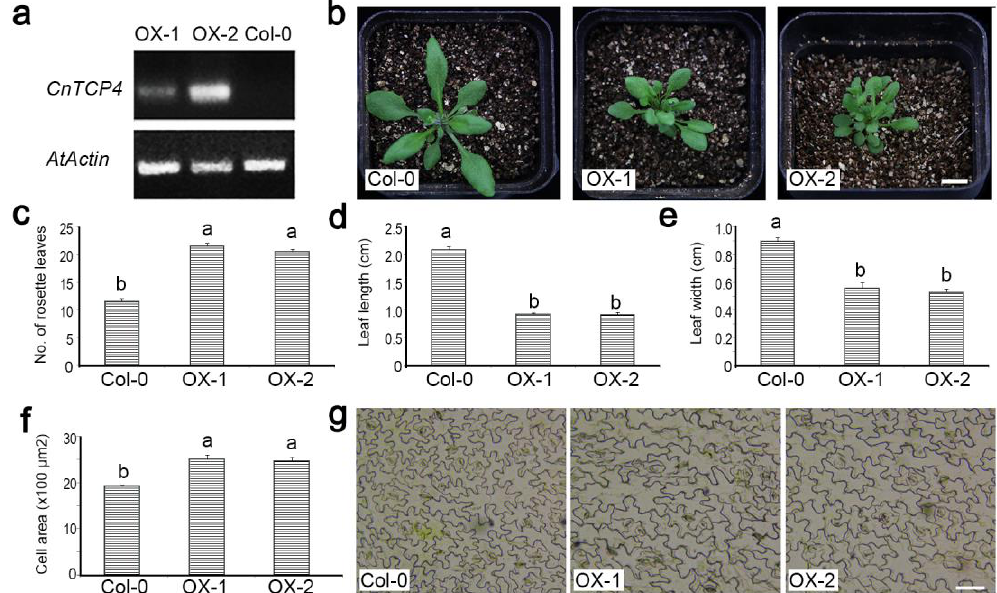
Figure 6. The phenotypic effect of constitutively expressing CnTCP4 in A. thaliana . ( a ) RT-PCR-based identification of the transgenic A. thaliana plants OX-1 and OX-2. ( b ) The appearance of 35-day-old wild-type Col-0, OX-1, and OX-2 plants. Bar: 1 cm. Quantification of leaf growth. ( c ) number of rosette leaves ( d ) length of the fifth leaf. ( e ) width of the fifth leaf. ( f ) surface area of cells in the fifth leaf. Values in ( c ) through ( f ) shown as mean ± SE (n = 10). ( g ) The appearance of epidermal cells sampled from the fifth leaf. Bar: 50 µm.